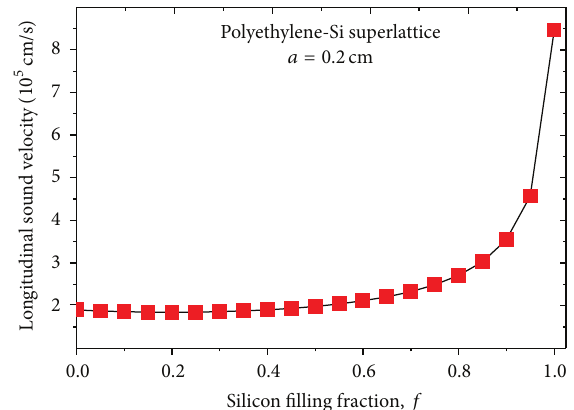
Figure 3: Effective sound velocity for transverse vibrational modes propagating along the growth direction of a Polyethylene-Si super- lattice. Here, solid line was obtained by using formula (33) and squares were obtained by using formula (35).